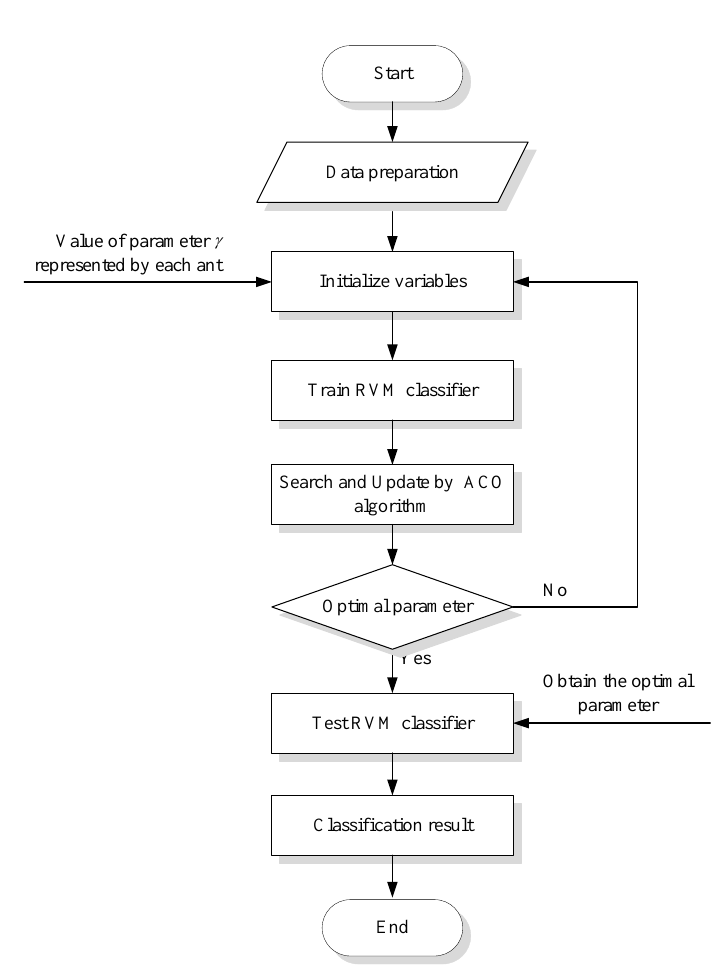
Figure 1. ACO-based parameter optimization of RVM